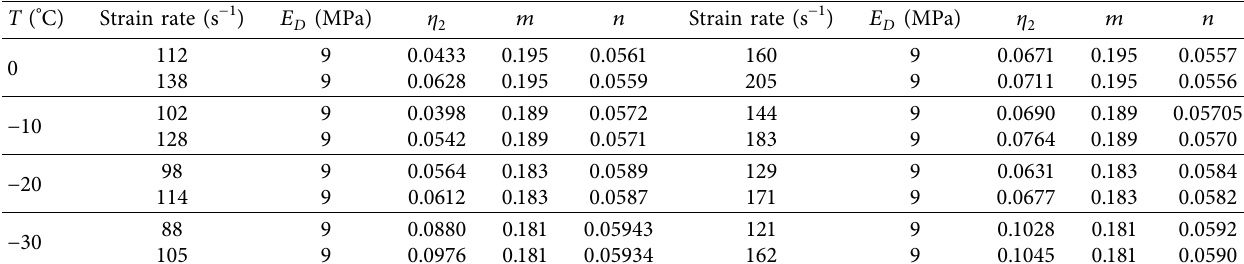
Figure 6: The relation between constitutive parameter and temperature. (a) η Table 2: The fitting parameter values of constitutive